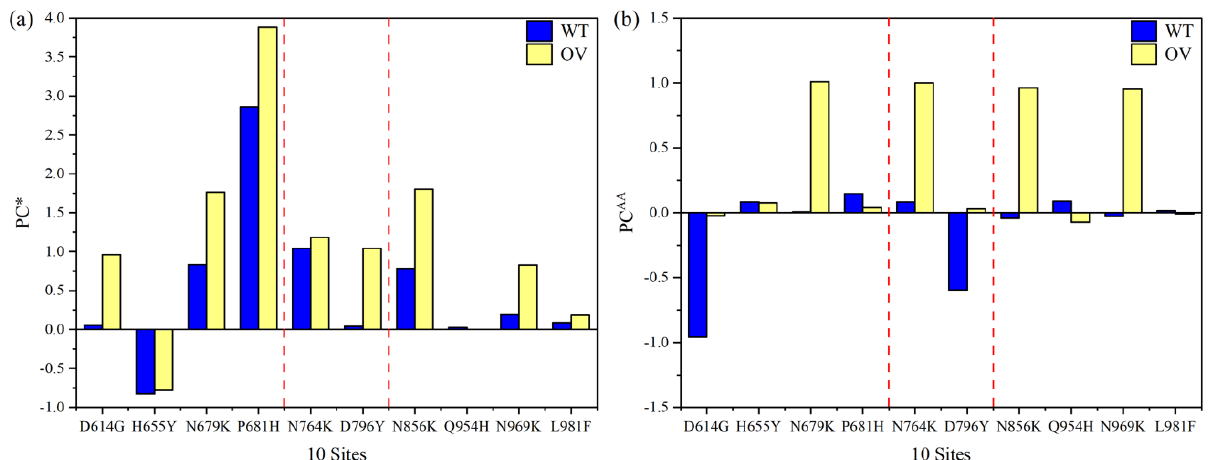
Figure 5. Partial charge distribution. ( a ) Partial charge per AABPU for 10 mutations, WT (blue) and OV (yellow). The two dashed red lines show the two cleavage sites. ( b ) PC AA is the partial charge distribution of the AA at each unique site.